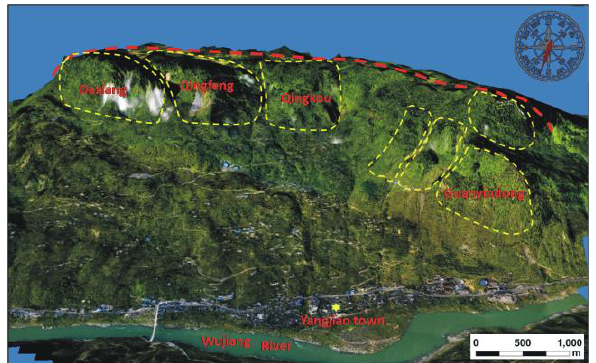
Figure 4. Geographic image of the Yangjiao landslide region.